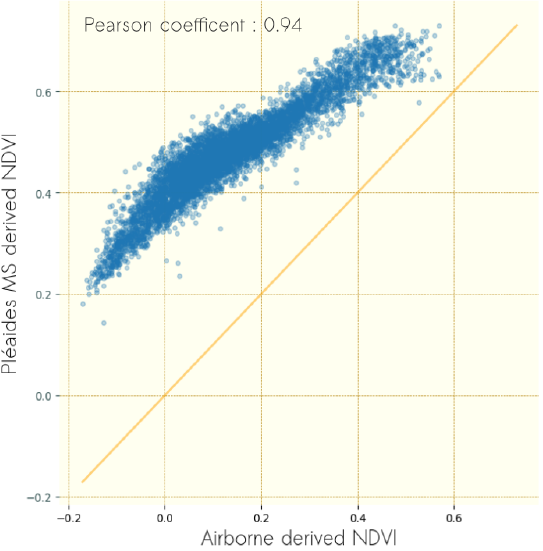
Figure 4. Scatterplot of mean NDVI values of windows computed for 0.5 m resolution airborne imagery and 2 m resolution Pléiades